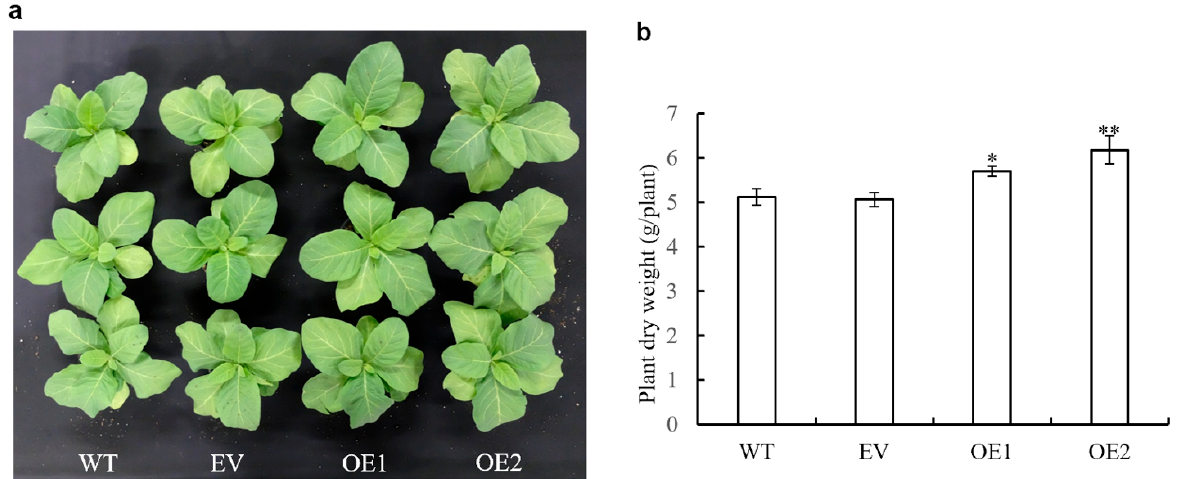
Figure 5. Growth characteristics of transgenic tobacco plants expressing AaPEPC1 . ( a ) Phenotypes of transgenic plants expressing AaPEPC1 (OE1 and OE2) as well as empty vector (EV), and wild-type plants (WT), grown in pots for 6 weeks under well-watered conditions. ( b ) Dry weight (shoot and root) of transgenic plants and WT. Values represent means ± SD (n = 3). * and ** indicate significant difference from that of WT at p < 0.05 and p < 0.01, respectively, by one-way ANOVA analysis with post-hoc Tukey